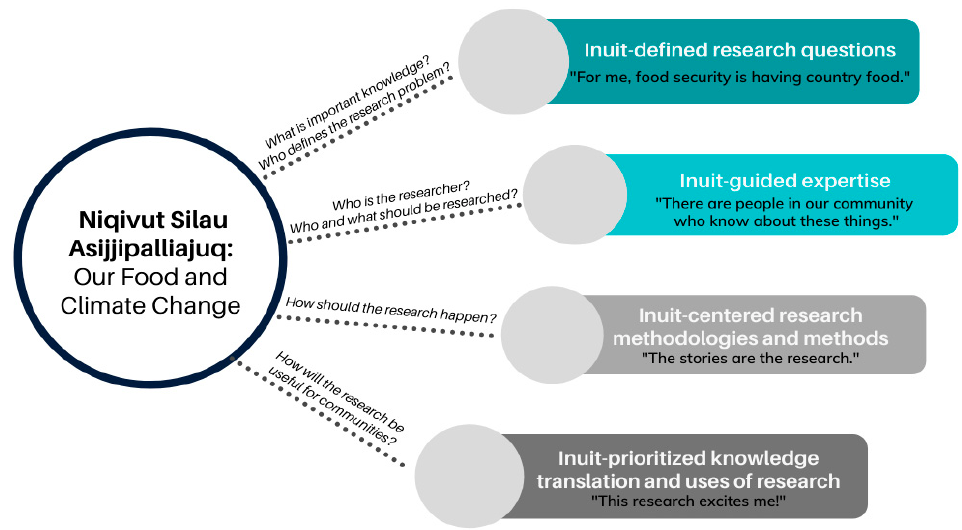
Figure 1. Four key elements addressed during the development of the “Niqivut Silalu Asijjipalli- ajuq: Our Food and Climate Change” research